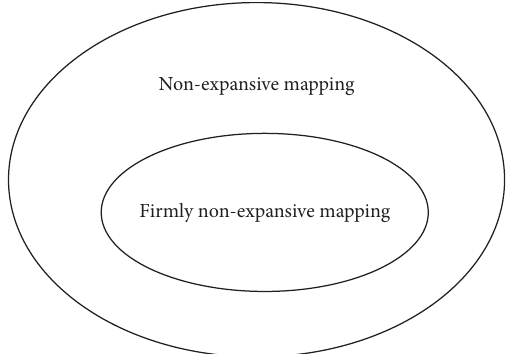
Figure 2: The relations of some nonlinear operators.